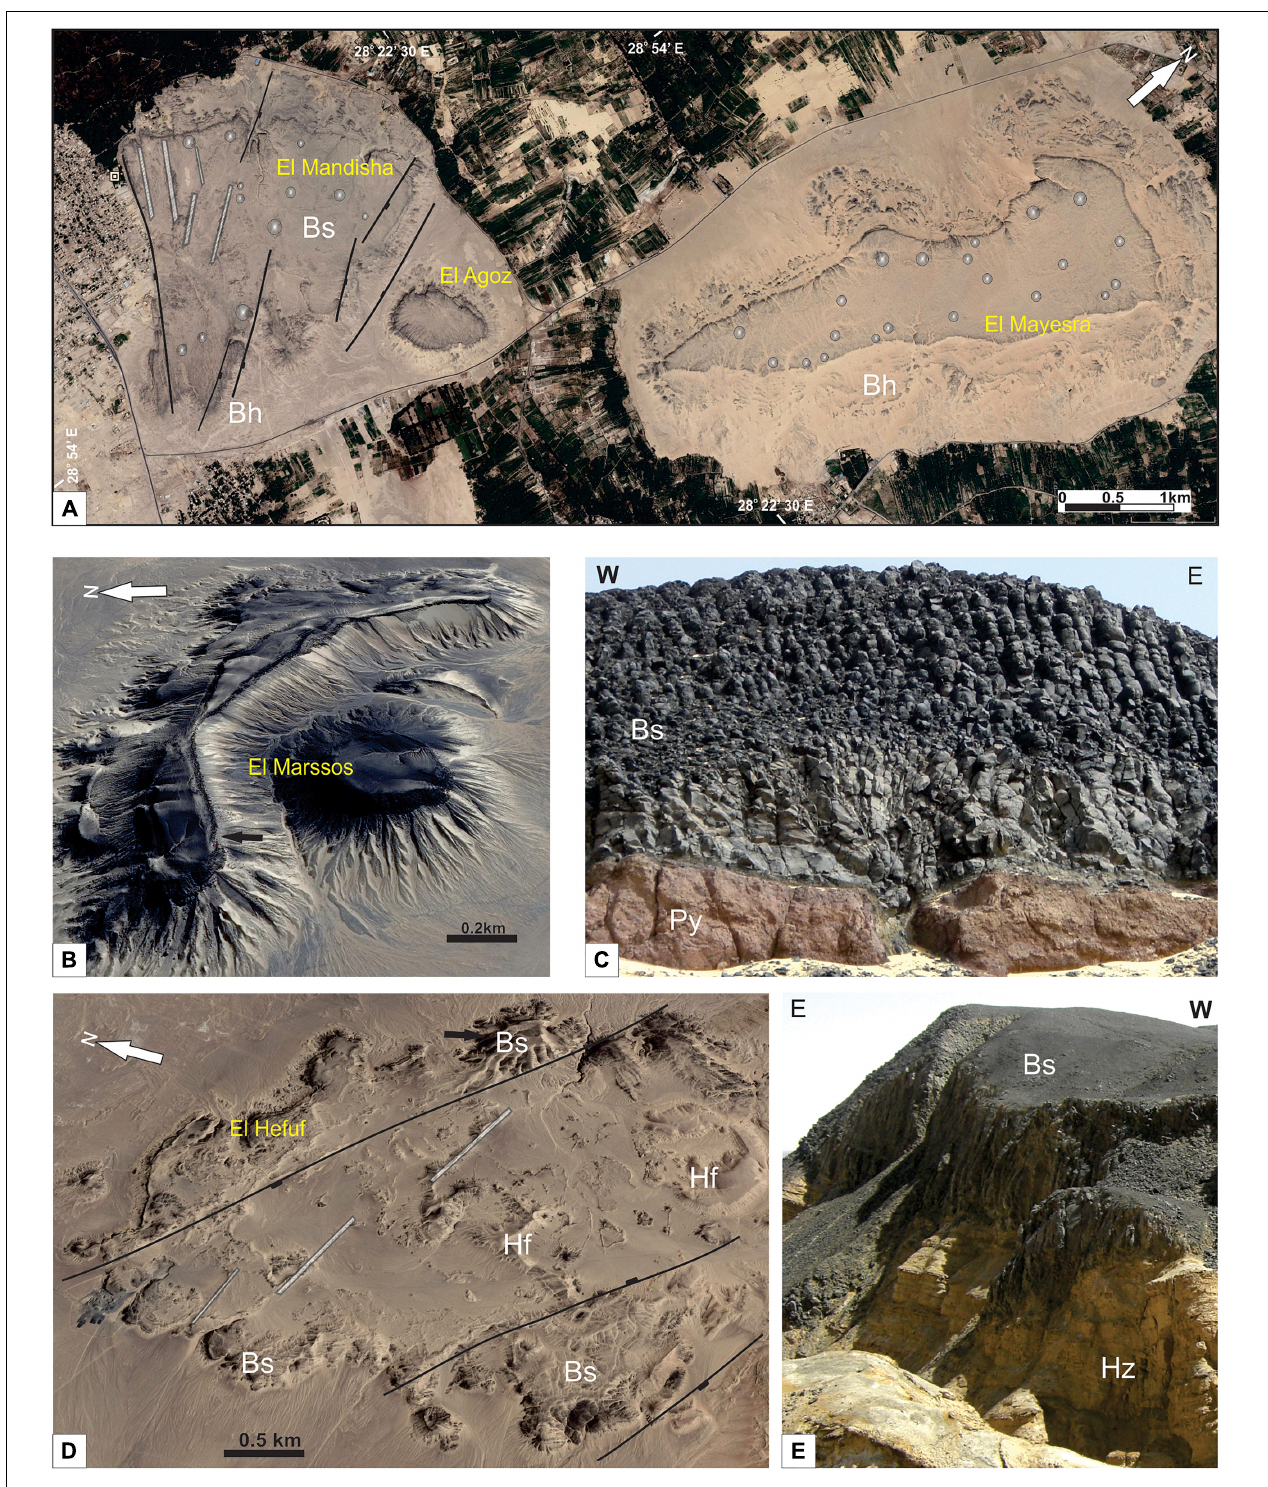
FIGURE 3 | Volcanic outcrops within the BD. (A) Google earth image of El Mandisha (left), El Agoz (center), and El Mayesra (right) volcanic flows with N60 o W dikes as feeders (gray bars) and tumuli features (circles), note the N30 o W normal faults dissecting the flows (black lines). (B) Google earth image showing the arched and plug liked outcrop of basaltic flow of El Marsos. (C) Volcanic conduit of basaltic flow within pyroclastic mound capped by columnar basalts at El Marsos outcrop. Additional details about this structure are provided in Khalaf and Hammed (2016). (D) Google Earth image shows basaltic occurrences at El Hefuf outcrop, Traced the NW- normal faults. (E) Basaltic flow of El Hefuf outcrop overlaying El Heiz Fm. Bs, basaltic flows; Bh, Bahariya Fm.; Py, Pyroclastic; Hf, El Hefuf Fm.; Hz, El Heiz Fm.